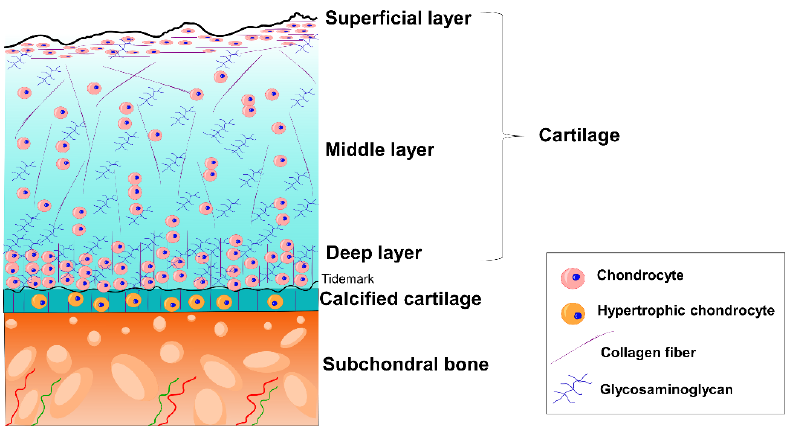
Figure 2. Schematic organization of osteochondral tissue.